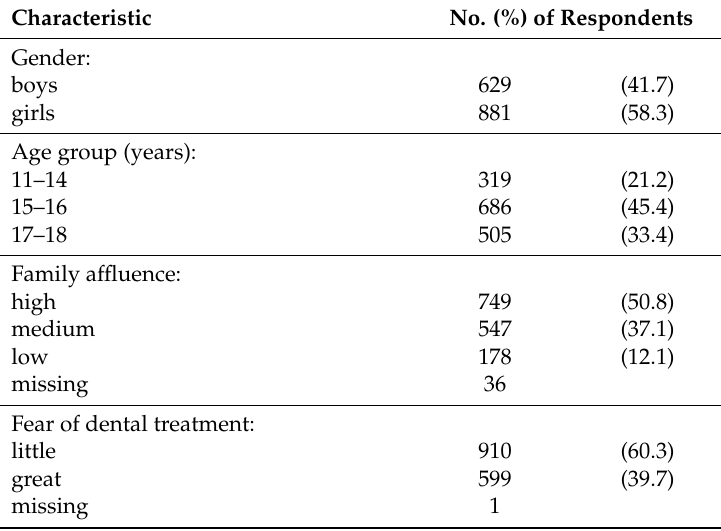
Table 1. Descriptive characteristics of a sample of adolescents in Lithuania (N = 1510) a